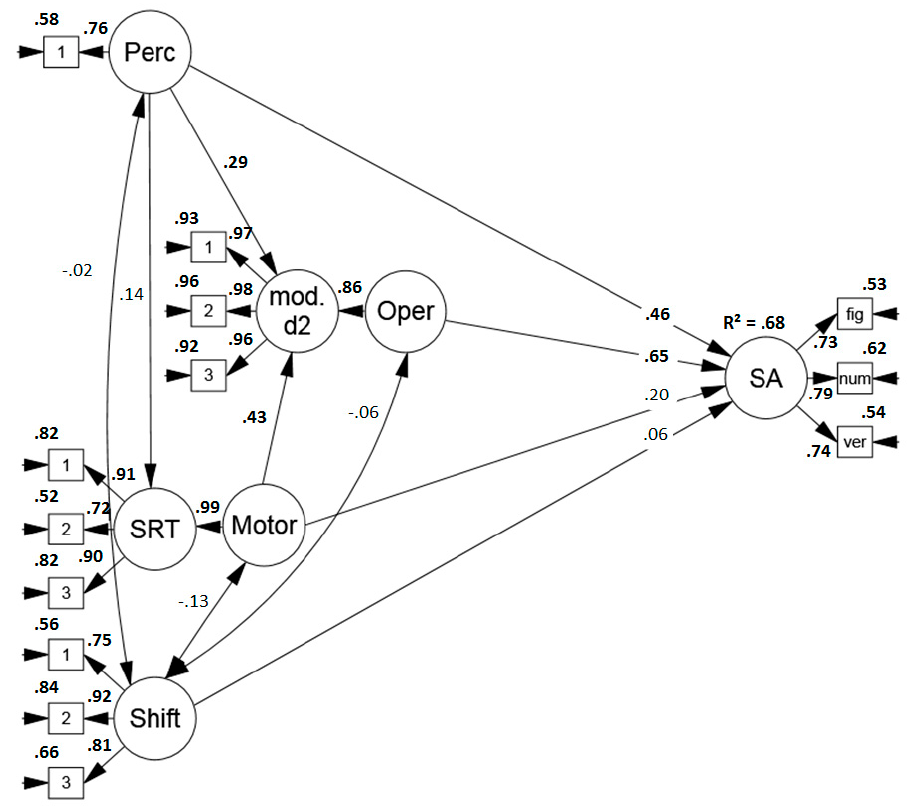
Figure 5. Standardized solution of the model predicting performance in sustained attention tests (convergent validity). Significant results are printed in boldface. Perc = perceptual speed, mod. d2 = modified d2, Oper = operation speed, SRT = simple reaction time task, Motor = motor speed, Shift = item shifting speed, SA = sustained attention, fig = figural task, num = numerical task, verb = verbal task.